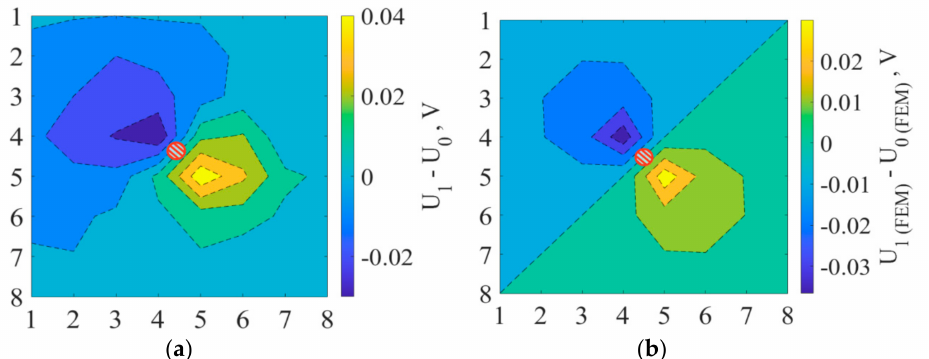
Figure 11. Experimental ( a ) and calculated using FEM ( b ) voltage distribution difference for the plate with the hole (case 1) and its undamaged state (case 0). Damaged areas are red line high- lighted. Vertical and horizontal numbers from 1 to 8 define the coordinates of electrodes on the composite plate.